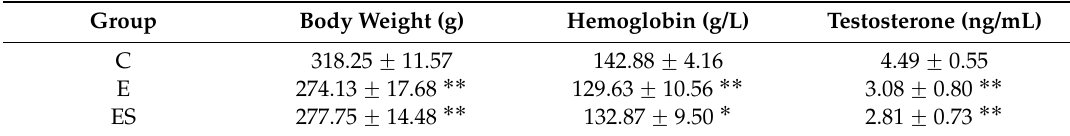
Table 2. Body Weight, Hemoglobin and Testosterone